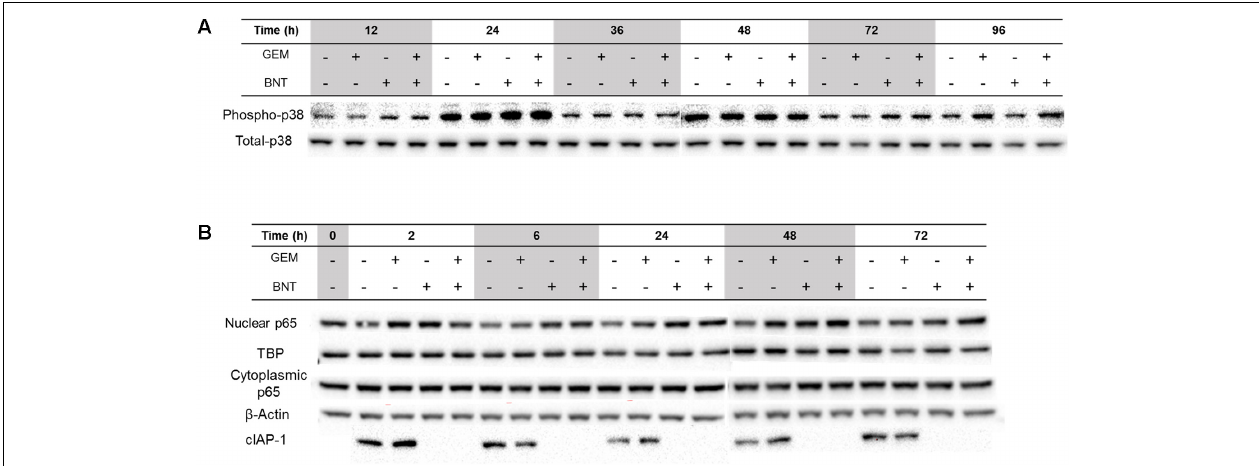
FIGURE 4 | Proteins in the MAPK-p38 and NF- κ B affected by gemcitabine and birinapant, alone and in combination. Pathways with significantly changed proteins are shown for (A) MAPK-p38 and (B) NF- κ B.